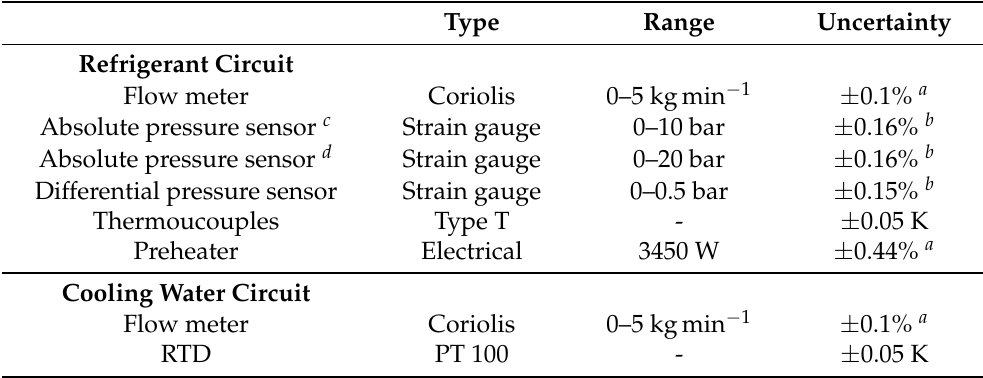
Table 3. List of instruments and their respective uncertainties.